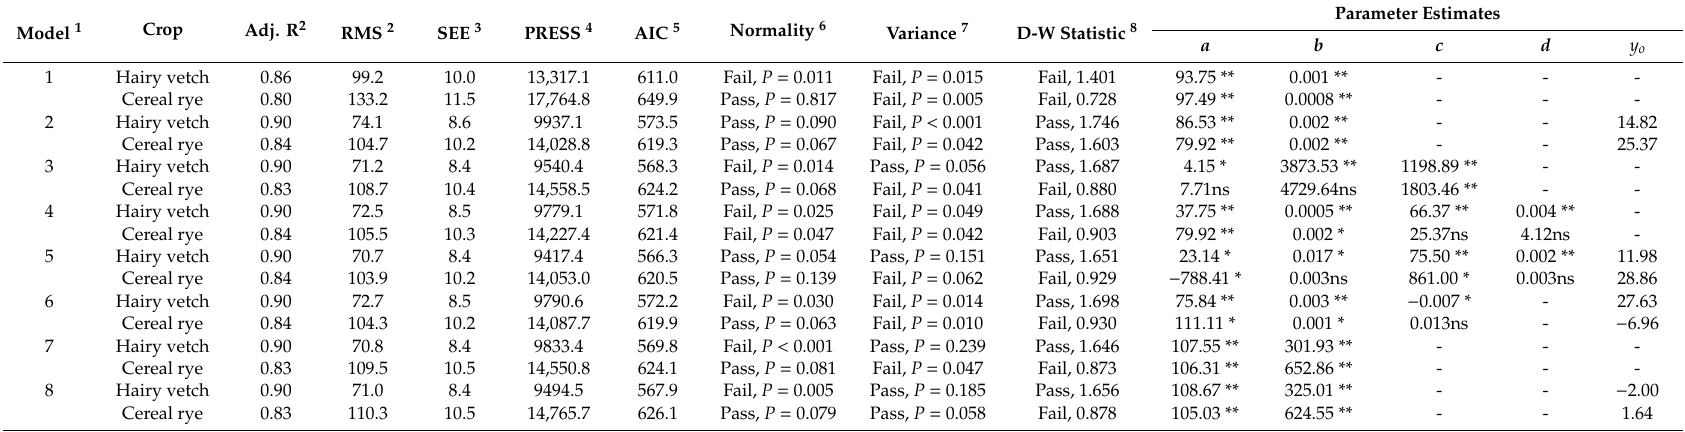
Table 3. Evaluation of models used to describe percent mass remaining of aboveground hairy vetch and cereal rye cover crops at Exp. 2 in 2017 and 2018 at Carbondale, IL. Data were pooled across tillage treatments, replicates, and years. Model 1